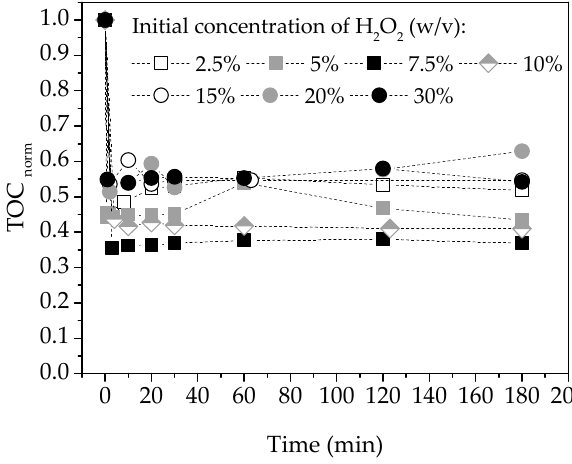
Figure 3. Normalized TOC values variation throughout the experiment time for different initial H 2 O 2 concentrations in the system (Catalyst/UV/H 2 O 2 ). Operating conditions: Catalyst used: FeCl 3 , initial TOC = 3113 ± 573 mg/L, pH = 3, T = 20 °C, stirring speed = 150 rpm, and [Catalyst]/[H 2 O 2 ] ratio = 0.03. The lowest value of TOC norm at the end of the experiments (0.368 ± 0.008) was obtained when 7.5% of initial H 2 O 2 concentration was used. The best range of initial H 2 O 2 concentrations to use for OMWs photodegradation was from 5% to 10% (w/v). In the same way, similar behaviors were obtained for TC norm , IC norm and TN norm .